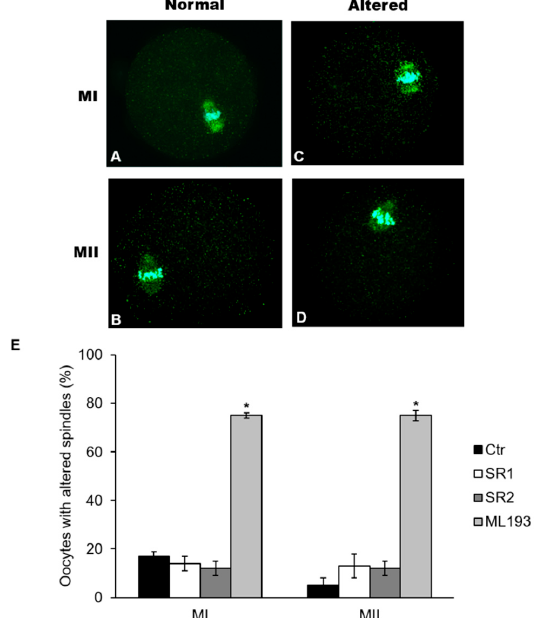
Figure 5. MI and MII spindle morphology and size. To obtain MI oocytes, OCCs were cultured in presence or absence (Ctr) of SR1, SR2, and ML193 (0.5 µ M) for 8 h. To obtain MII oocytes, OCCs were collected 8 h after hCG and cultured in vitro for 5 h. Spindles were stained with anti- α / β -tubulin antibody (green) and chromosomes with DAPI (cyan). Representative images of normal MI ( A ) and MII ( B ) spindles and of altered MI ( C ) and MII ( D ) spindles. Magnification: × 630. ( E ) Oocytes percentages of MI and MII altered spindles in presence of CBRs antagonists. Data are expressed as mean ± SEM of 3 independent experiments. * p < 0.05 vs Ctr oocytes of the same experimental group.